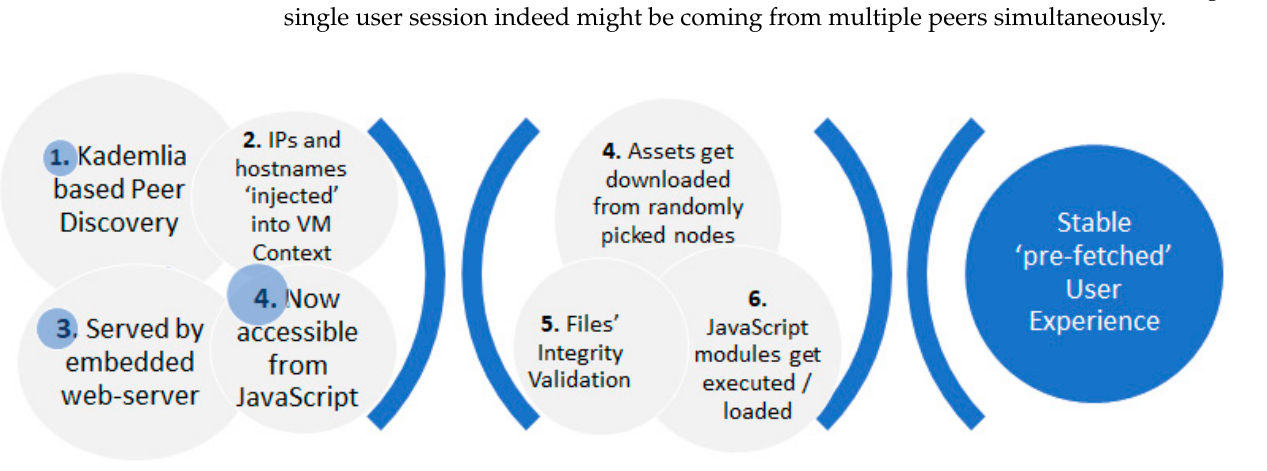
Figure 4. Steps to be taken by the decentralized bootloader (UI). Figure 4 . Steps to be taken by the decentralized bootloader (UI).